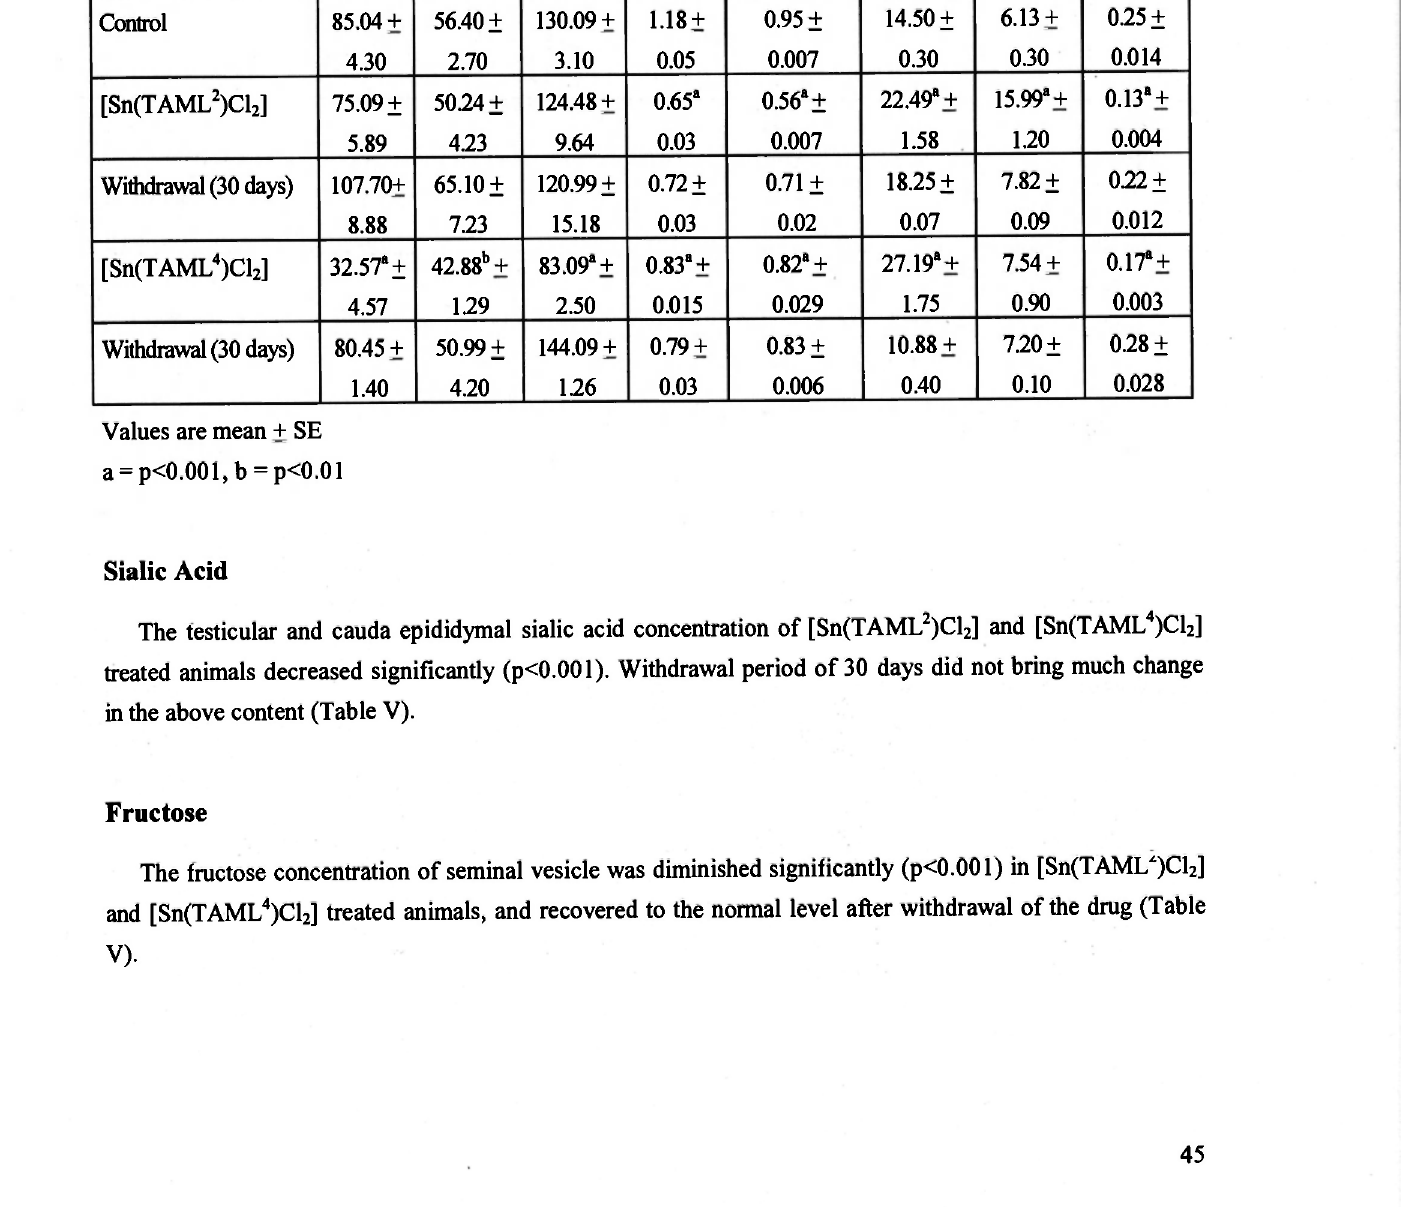
] and [Sn(TAML )C1 ] 2 2